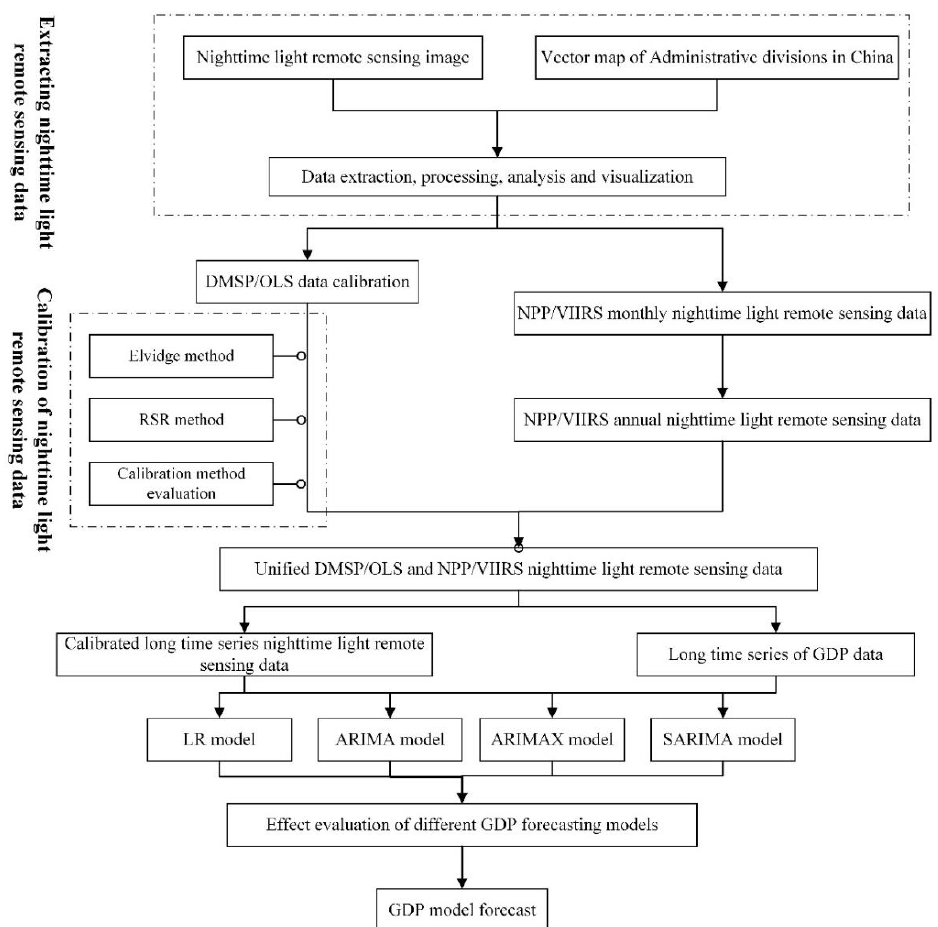
Figure 2. The workflow of the GDP estimation using NTL data.